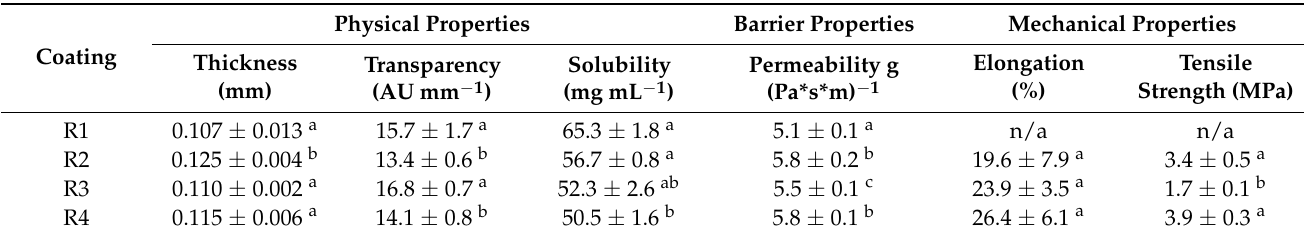
Table 2. Results of film characterisation. Barrier Properties Mechanical